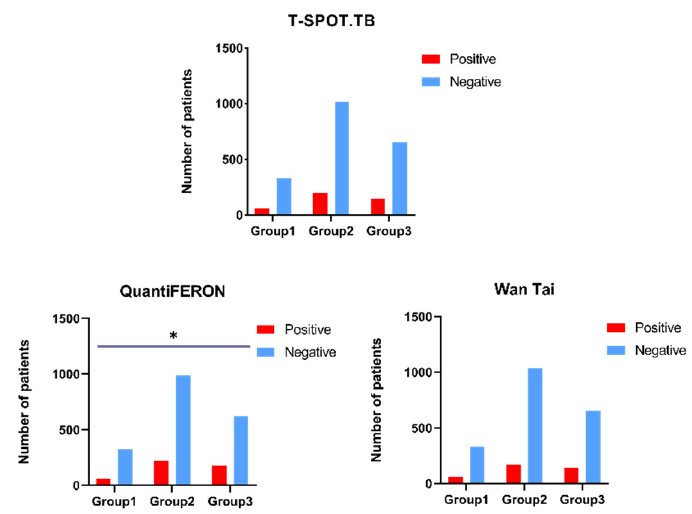
Figure 2. The comparison of different groups with different IGRA assays. Group 1: CD4 + T cell number of < 200/ μ L; Group 2: CD4 + T cell number of 200–500/ μ L; Group 3: CD4 + T cell number of > 500/ μ L; *: p ≤ 0.05.